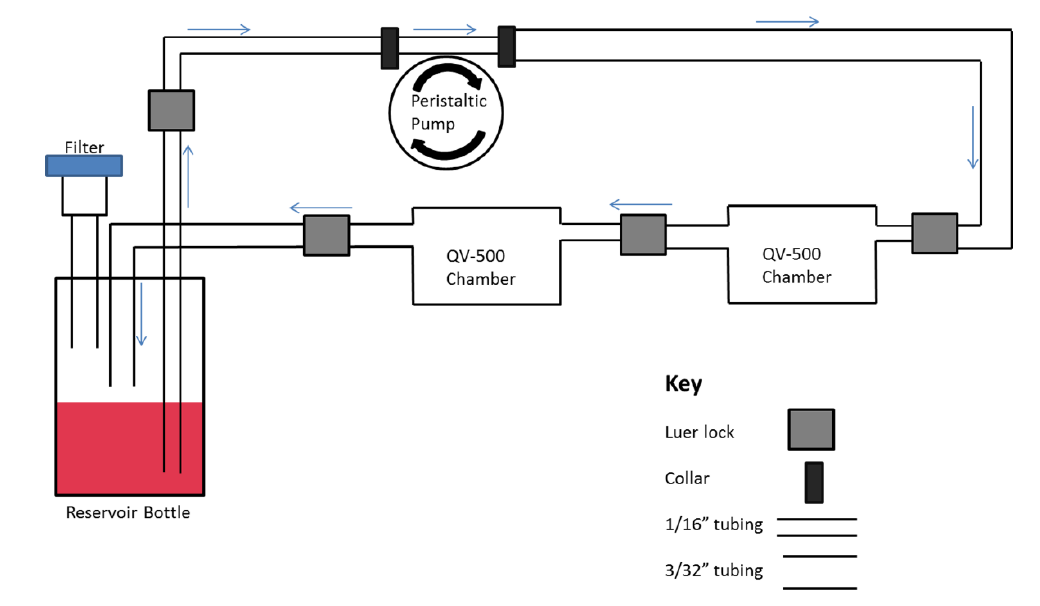
Figure 4. Schematic representation of a two chamber QV500 flow system. When assembled the system forms a closed recirculating loop allowing unidirectional flow at a speed determined by the peristaltic pump. The internal dimensions of the QV500 chamber are the same as a 24-well plate. The tubing and chambers are gas permeable and the reservoir bottle has an air filter attached to allow for gas exchange.